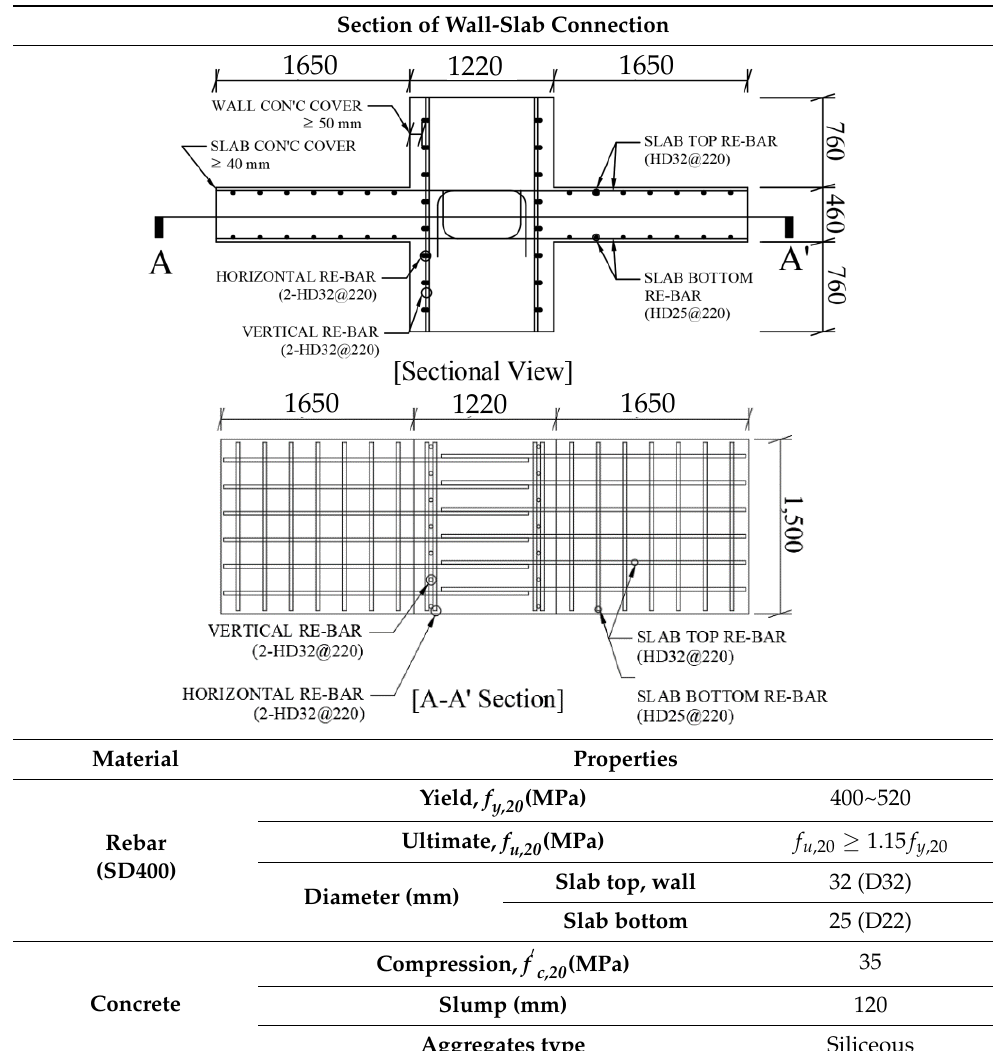
Table 4. Section and mechanical properties of the wall-slab connection.